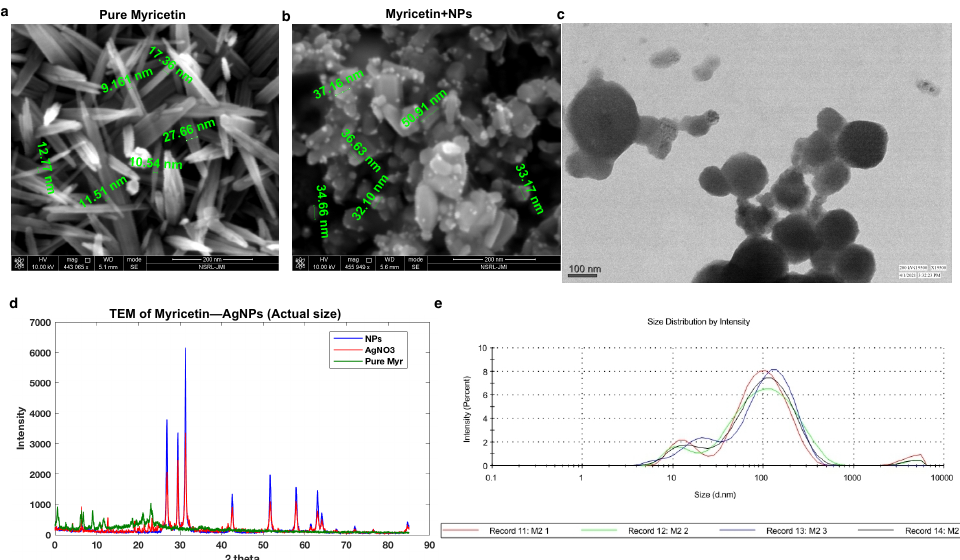
Figure 3. ( a ) Scanning electron microscope (SEM) of pure Myricetin, ( b ) SEM of Myricetin coated with NPs (AgNPs), ( c , e ) TEM of Myricetin—AgNPs, ( d ) comparative XRDs of NPs, AgNO 3 , and Myricetin, and ( e ) particle diameter analysis for AgNPs (dynamic light scattering (DLS)